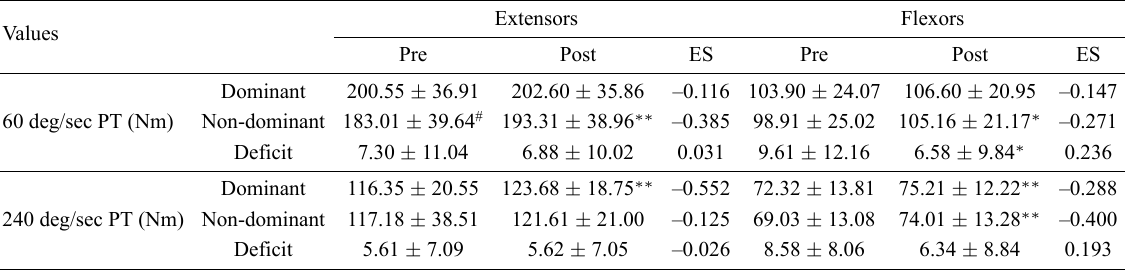
Table 4. Absolute values of isokinetic peak torque, total work, average power, and endurance ratio on extensors and flexors of knee joint for high school soccer players